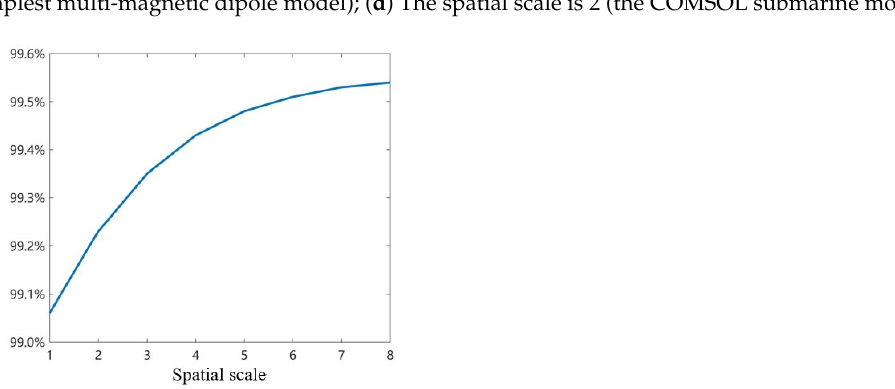
Figure 11. Total magnetic field distribution calculated with the simplest multiple magnetic dipole model and the COMSOL submarine model. ( a ) The spatial scale is 1 (the simplest multi-magnetic dipole model); ( b ) The spatial scale is 1 (the COMSOL submarine model); ( c ) The spatial scale is 2 (the simplest multi-magnetic dipole model); ( d ) The spatial scale is 2 (the COMSOL submarine model).